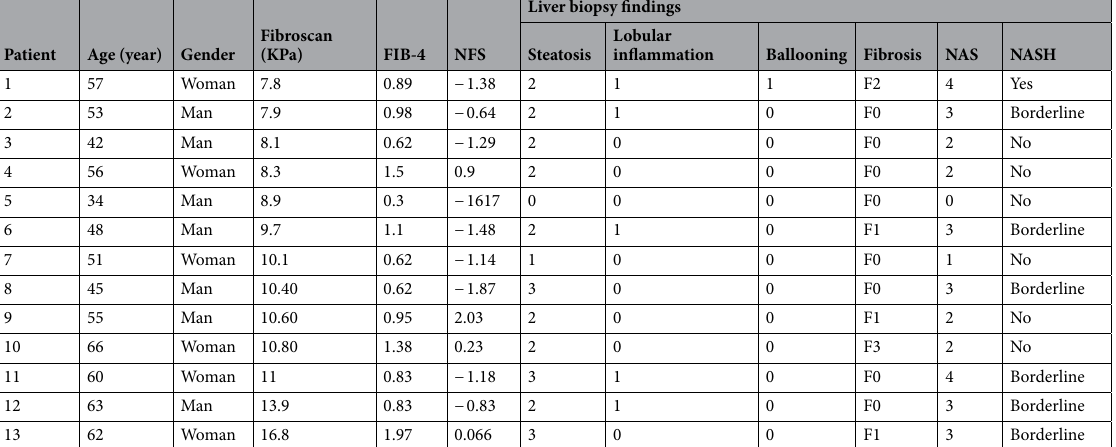
Table 3. Results of liver biopsy in 13 patients with liver stiffness measurement > 7.8 kPa by transient elastography. FIB-4 is a non-alcoholic fatty liver disease (NAFLD) fibrosis score: FIB-4 < 1.3 Low Risk of Liver Fibrosis, FIB-4 130–2.26: Indeterminate Risk of Liver Fibrosis "grey area", FIB-4 > 3.26: High Risk of Liver Fibrosis; NFS: NAFLD fibrosis score: NFS < − 1.455: Low Risk of Liver Fibrosis, NFS −